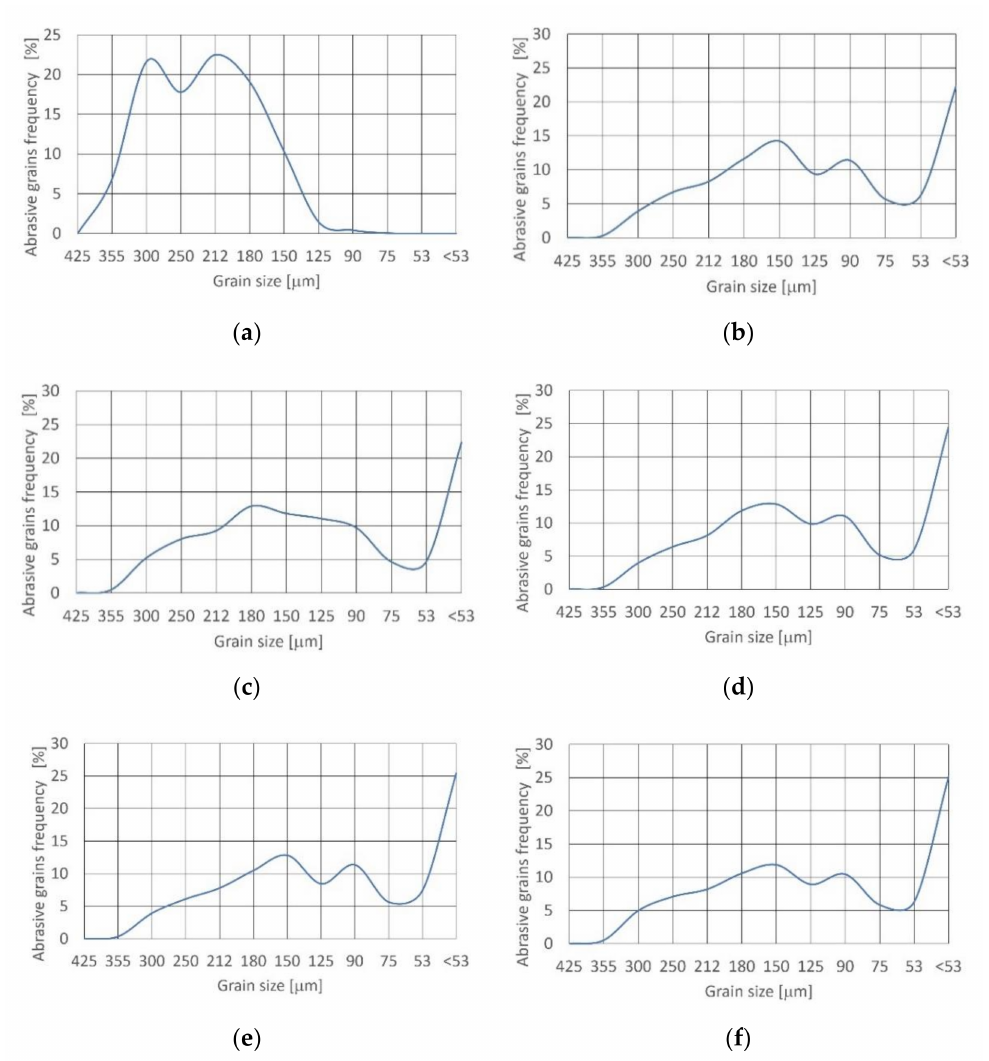
Figure 4. Size distribution of recycled garnet grain at concentration: ( a ) fresh; ( b ) 15%; ( c ) 17.5%;